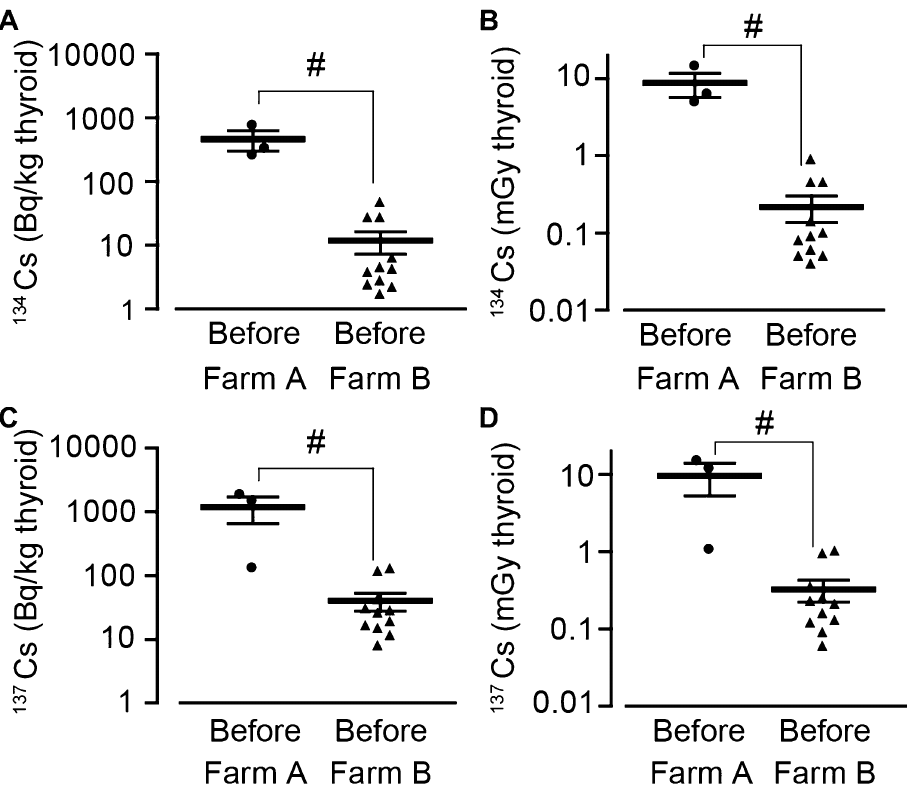
Figure 5. Internal exposure dose by 134 Cs and 137 Cs in cattle thyroid. Thyroids were dissected and the levels of 134 Cs and 137 Cs were measured. ( A , B ) The summary of thyroid 134 Cs (Farm A, black circle, n = 3; Farm B, black triangle, n = 11), shown as ( A ) the becquerel and ( B ) the calculated internal exposure dose until October 2016. ( C , D ) The summary of thyroid 137 Cs (Farm A, black circle, n = 3; Farm B, black triangle, n = 11), shown as ( C ) the becquerel and ( D ) the calculated internal exposure dose until October 2016. Data are presented as mean ± SEM. # P < 0.05.